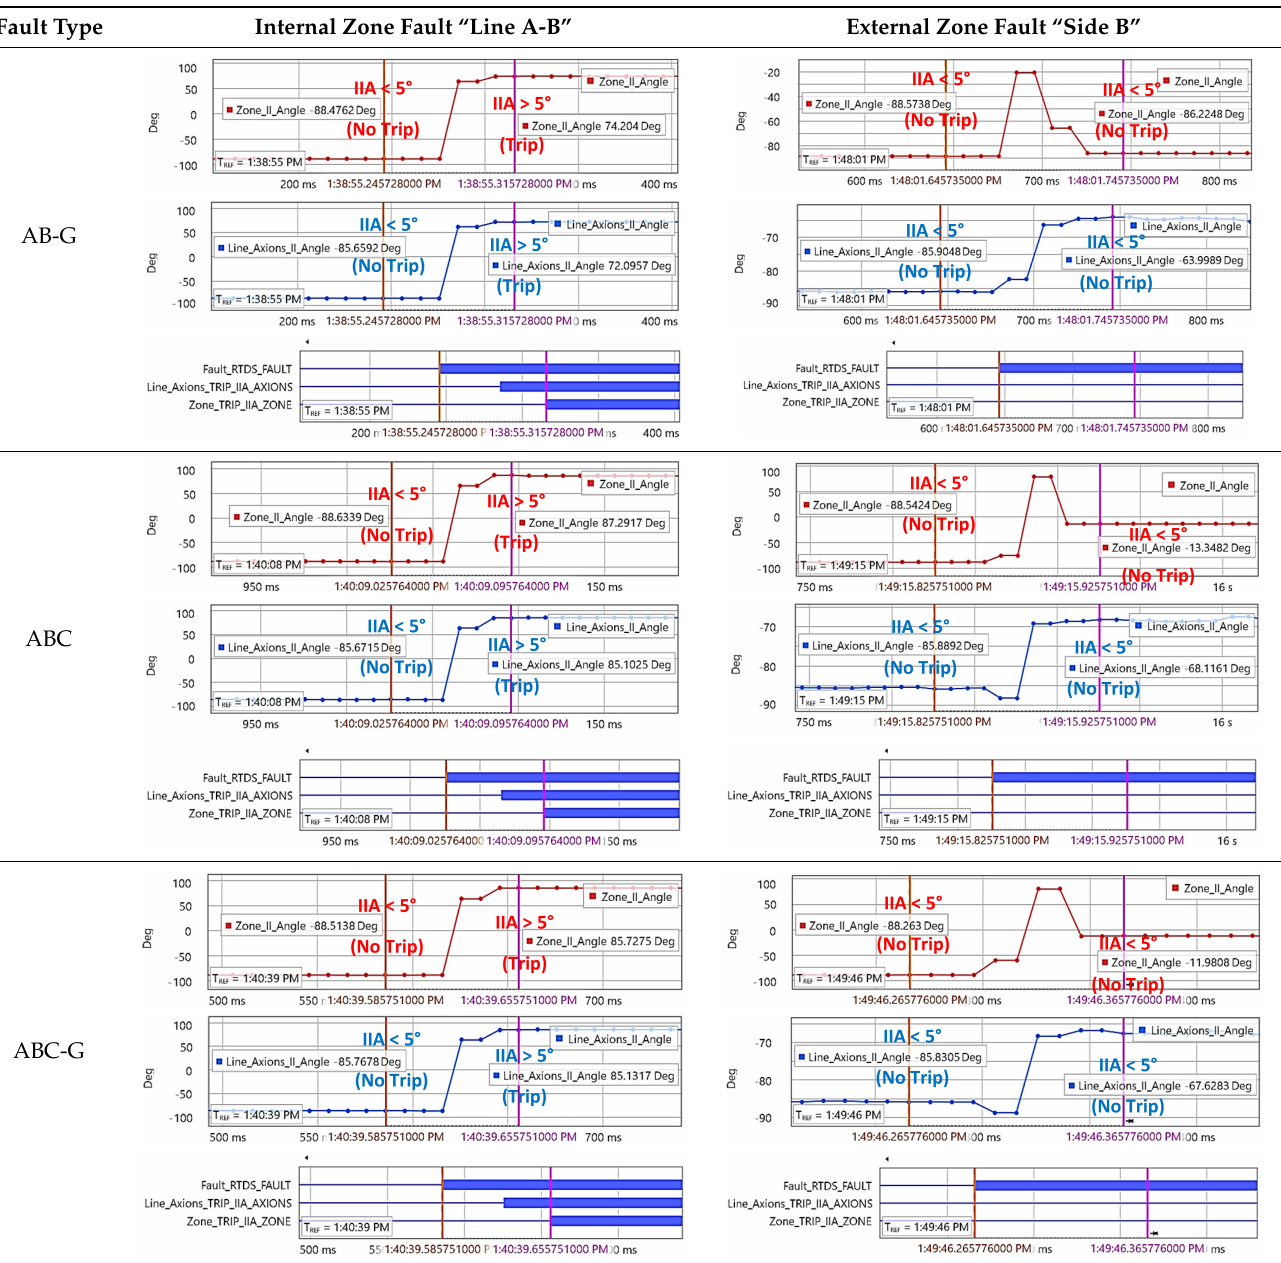
Table 9. IIA Zone behaviour with RES (Part 2 of